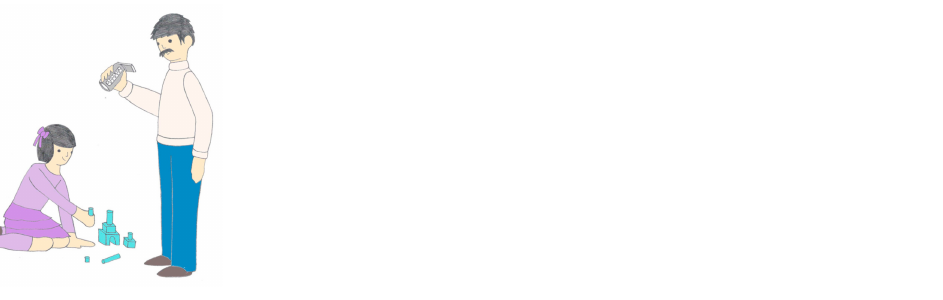
Figure 1. Image to Elicit Gender Agreement Mismatch with the Sentence “The father filmed